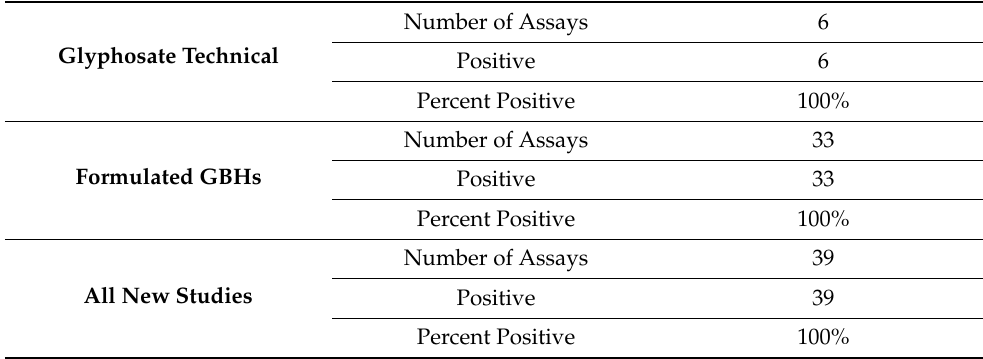
Table 4. Non-Mammalian In Vivo Genotoxicity Assays Published Since the EPA and IARC Reviews of Glyphosate and GBH Oncogenicity.